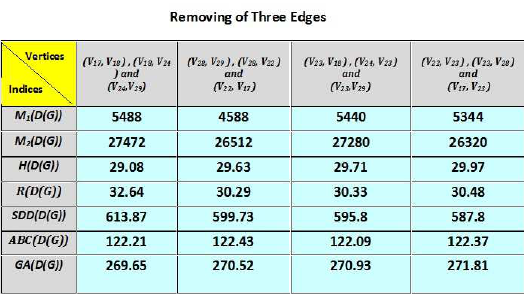
Fig. 6 Removing of three edge sets of healthy Liver graph